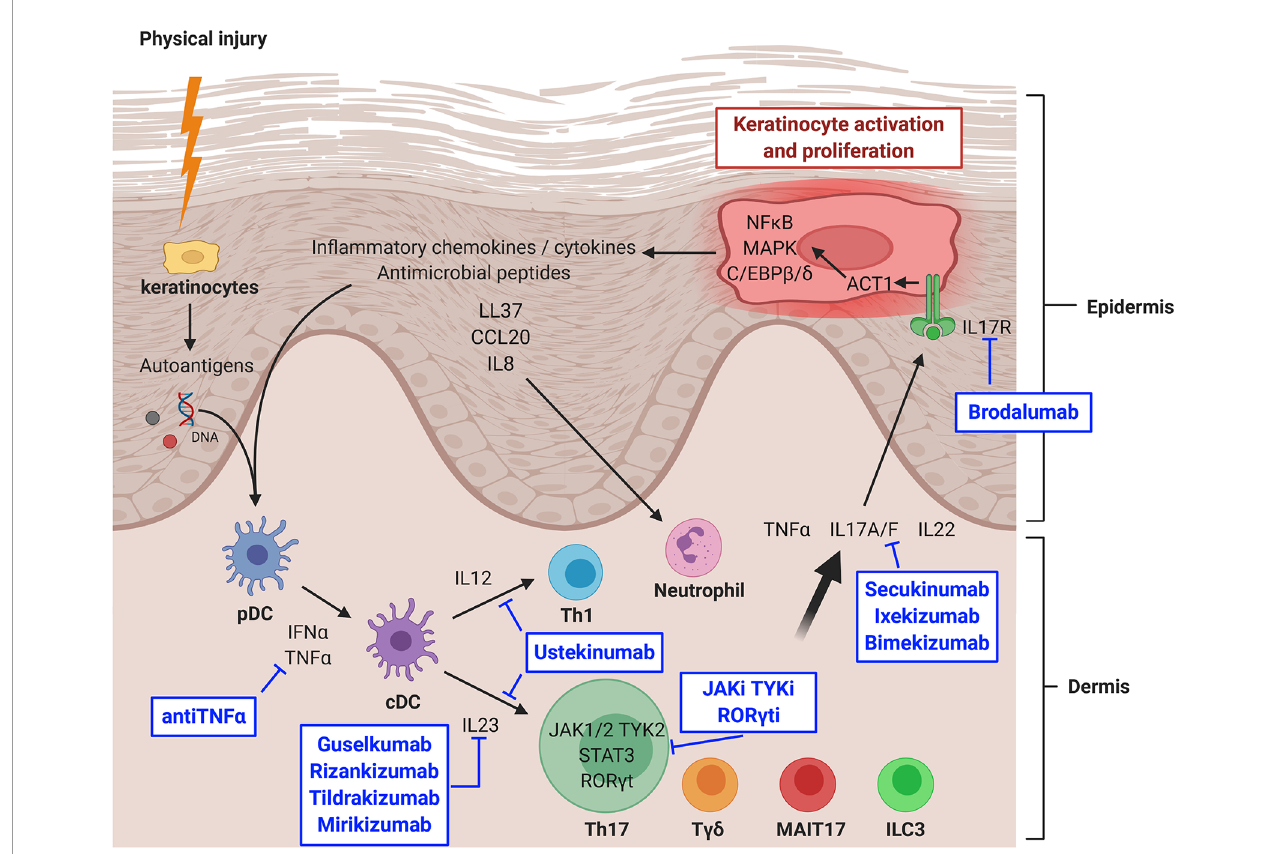
FIGURE 1 | IL23/IL17 axis in psoriasis and targeted therapies. CCL20, chemokine (C-C motif) ligand 20; cDC, classical dendritic cell; IFN a , interferon alpha; IL, interleukin; IL17R, IL17 receptor; ILC, innate lymphoid cell; JAK, Janus kinase; JAKi, JAK inhibitor; MAIT, mucosal associated invariant T cell; MAPK, mitogen activated protein kinase; NF k B, nuclear factor-kappa B; pDC, plasmacytoid dendritic cell; ROR g t, RAR-related orphan receptor gamma t; ROR g ti, ROR g t inhibitor; STAT, signal transducer and activator of transcription protein; T gd , gamma delta T lymphocyte; Th, T helper lymphocyte; TNF a , tumor necrosis factor alpha; TYK, tyrosine kinase; TYKi, TYK inhibitor. Created with